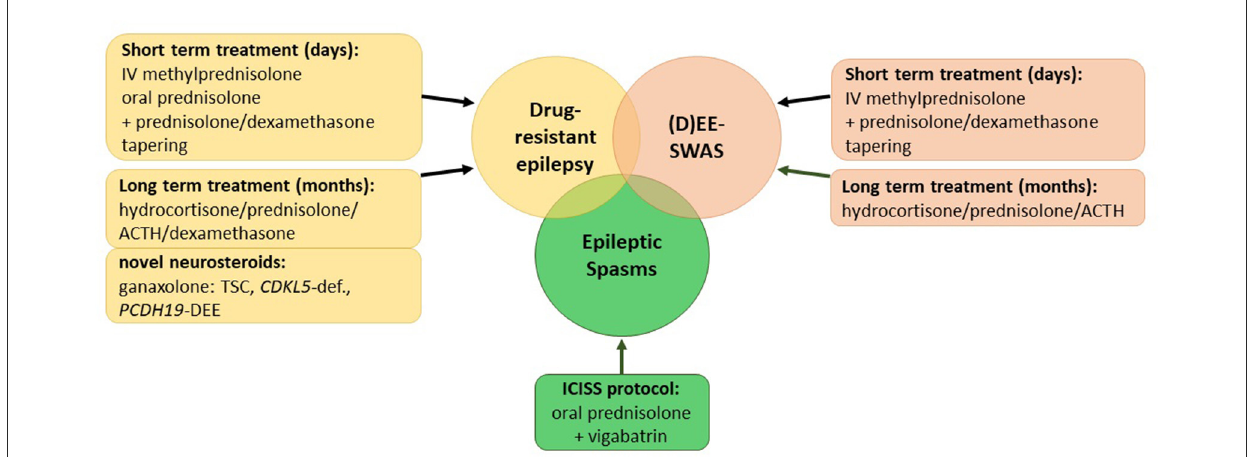
FIGURE1 Overview of current corticosteroid regimes in childhood epilepsies. (D)EE-SWAS, developmental and epileptic encephalopathy with spike-and-wave activation in sleep; TSC, tuberous sclerosis complex.